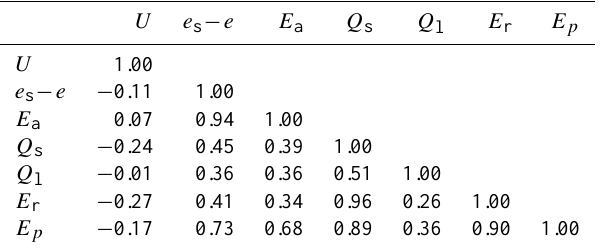
Table 4. Cross-correlation coefficients between potential evapo- ration E p and relevant quantities. The analysed timeseries are the normalised anomalies for the period July 1983–June 2008.